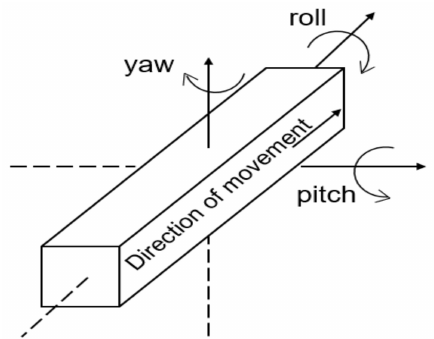
Figure 1. Definition of three-dimensional attitude